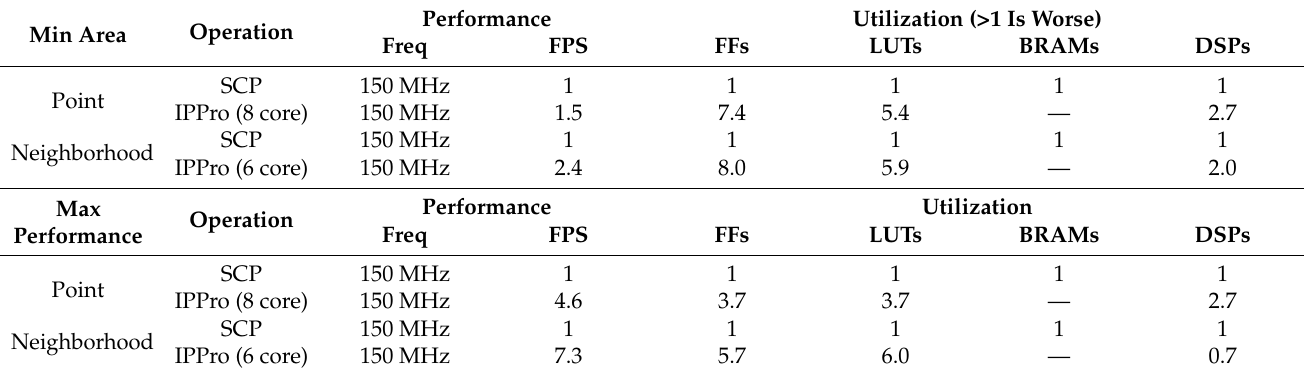
Table 3. Ratios for SCP to IPPro for performance and utilization (>1 is worse).